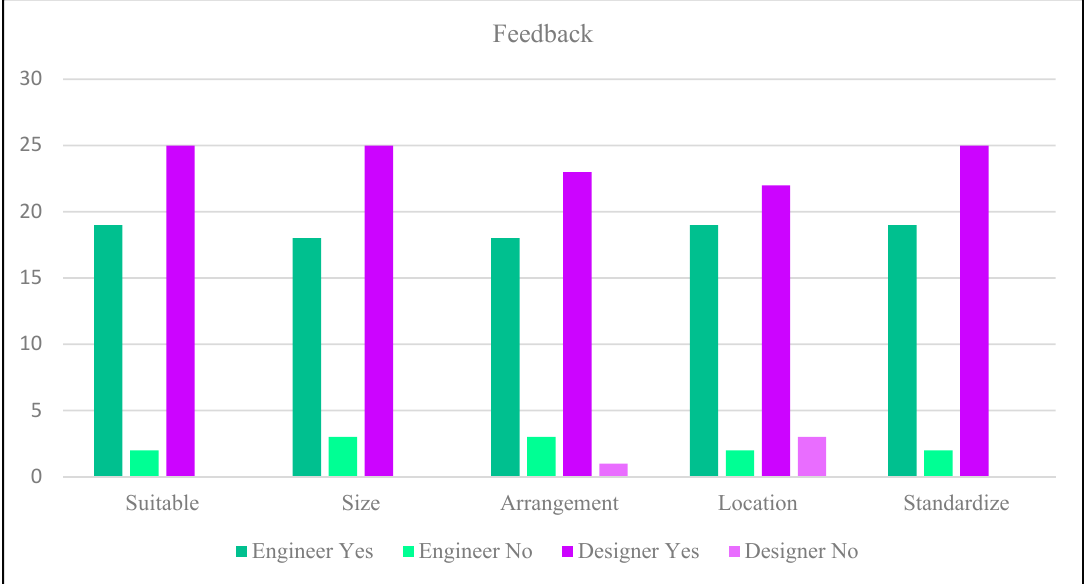
Figure 10. Participants feedback results.